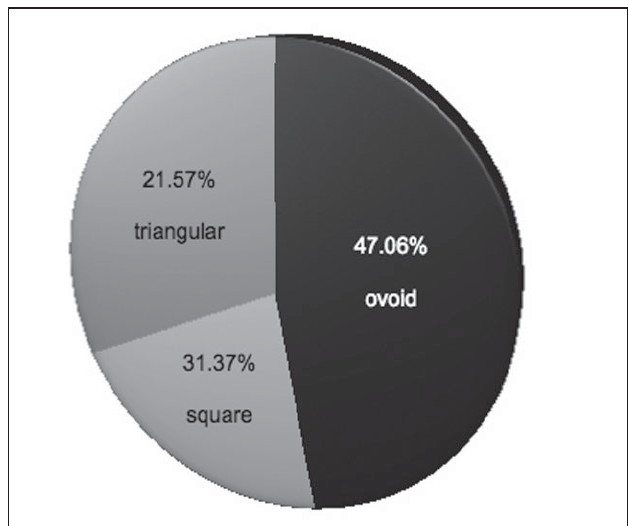
Fig. 5. Prevalence of maxillary central incisor shape.